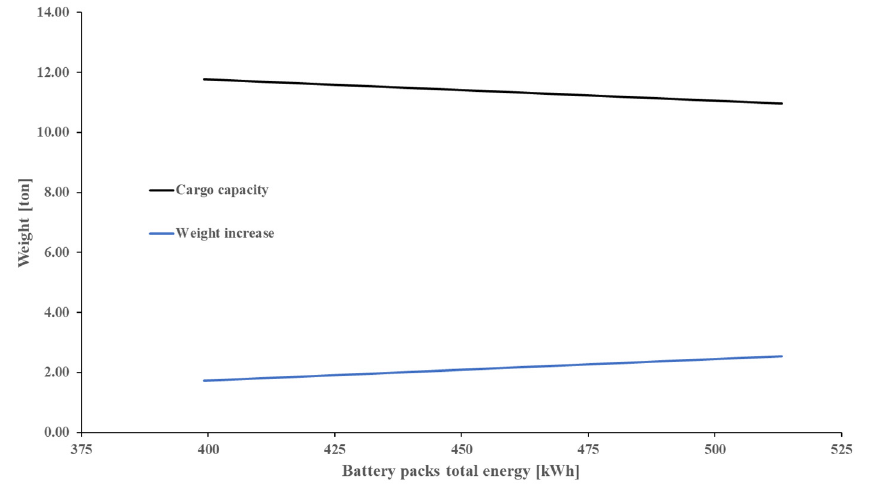
Figure 9. Effect of battery pack size on cargo capacity.